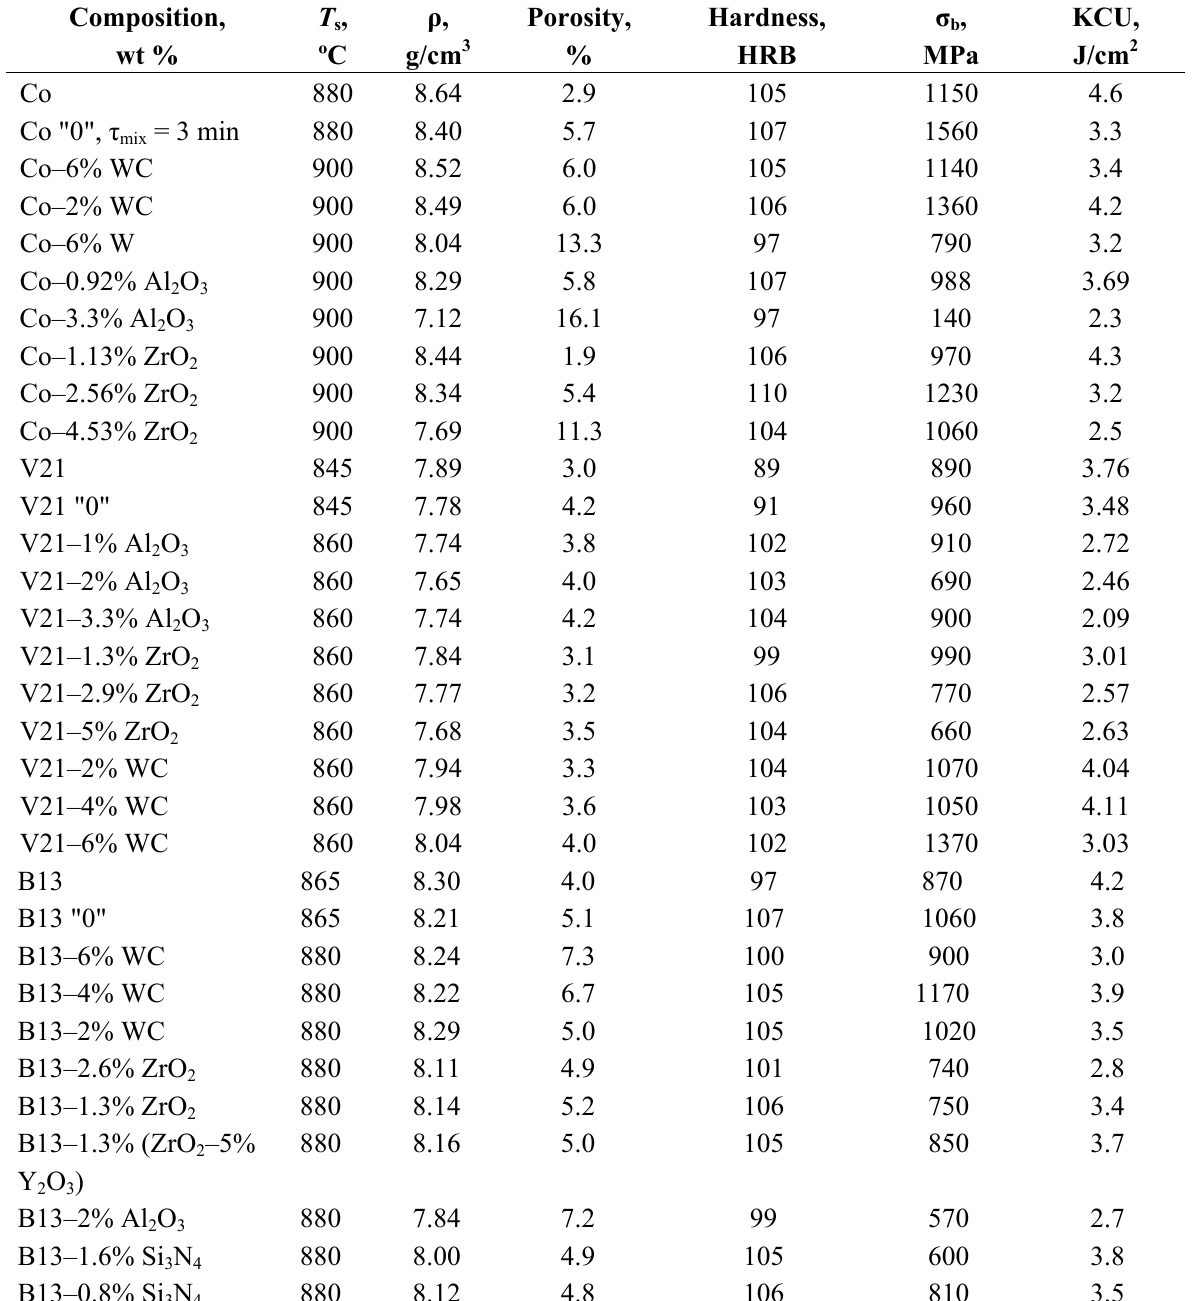
Table 1. Mechanical properties of hot-pressed DS